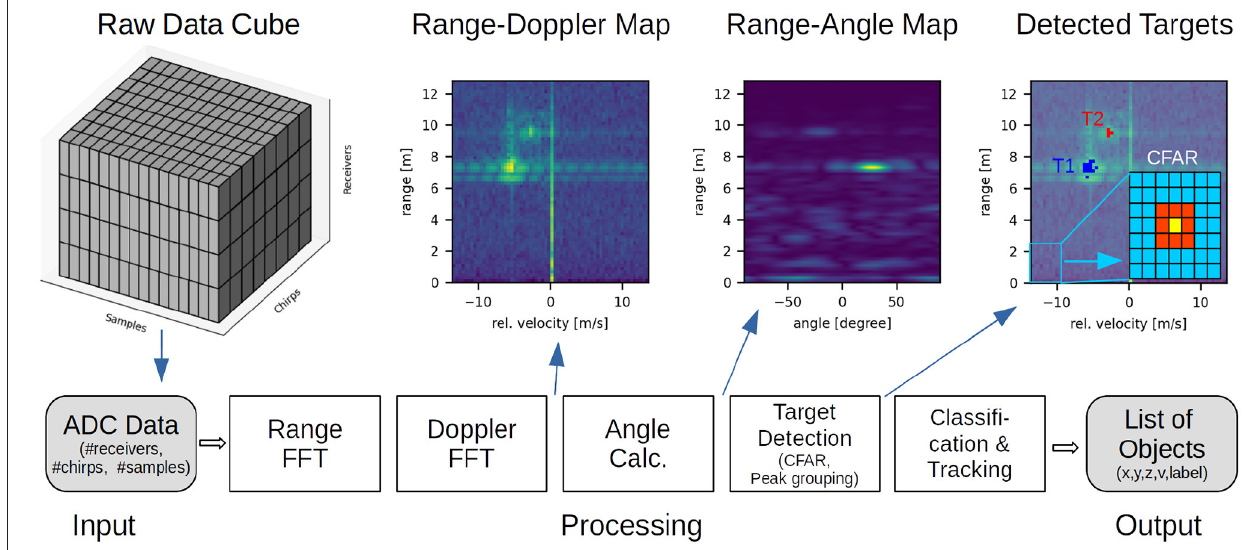
FIGURE 3 | Conventional radar processing chain: The raw input data (ADC samples from multiple chirps and receivers) is processed by a sequence of algorithms yielding a list of detected objects with coordinates and labels. Intermediate data representations are shown in the top. In the top right figure, the inset shows the CFAR kernel for target detection with cell under test (yellow), guard cells (red), and training cells